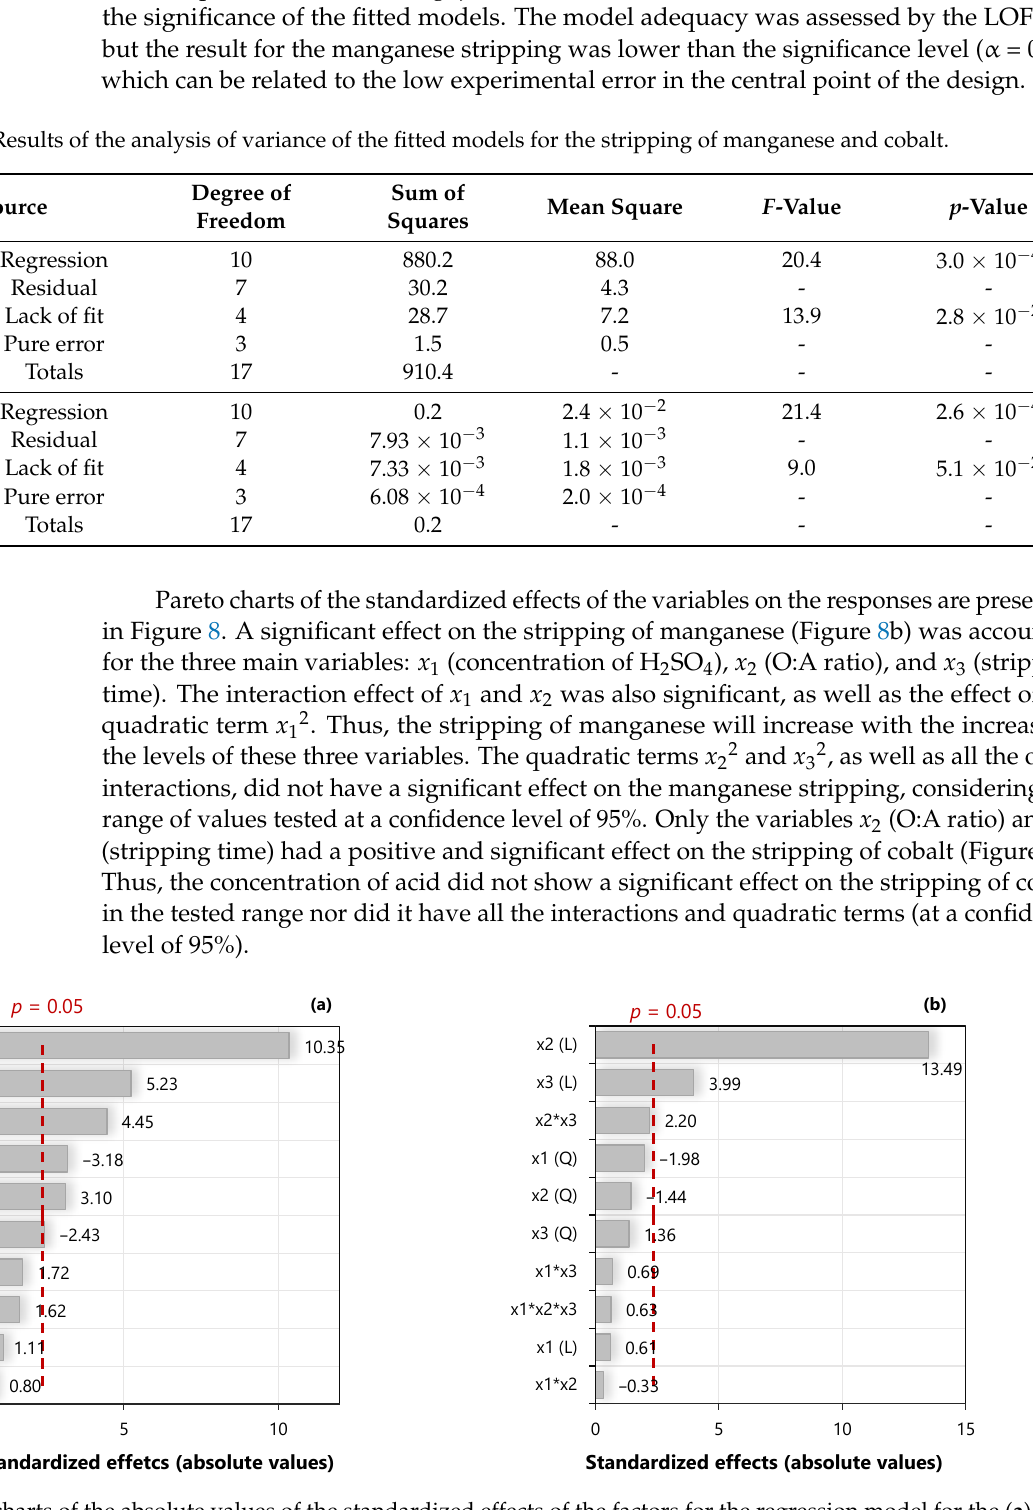
Figure 8. Pareto charts of the absolute values of the standardized effects of the factors for the regression model for the ( a ) manganese stripping and ( b ) for the cobalt stripping. Significance level α = 0.05. Legend: x 1 : molar concentration of H 2 SO 4 , x 2 : O:A ratio, x 3 : stripping time, (Q): quadratic terms, (L): linear terms.